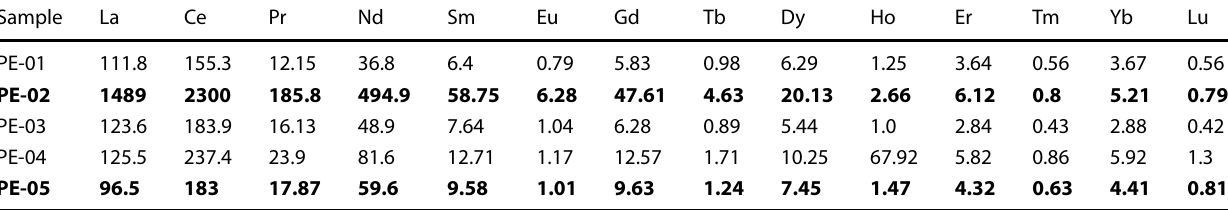
Table 1 Concentration of rare earth elements obtained with inductively coupled plasma mass spectrometry in samples extracted from 5 dif- ferent locations in Capacsaya site in Cusco, Peru